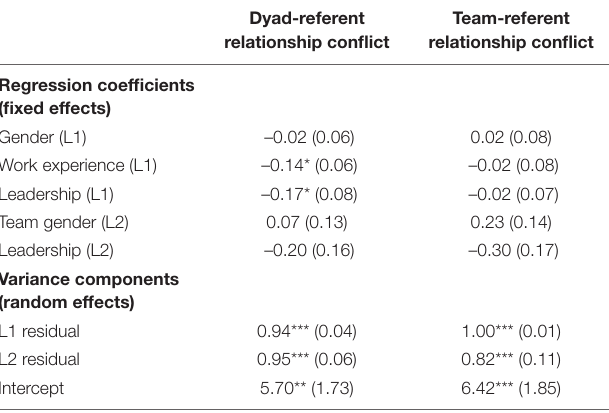
TABLE 3 | Leadership at midpoint predicting team conflict late in the team life